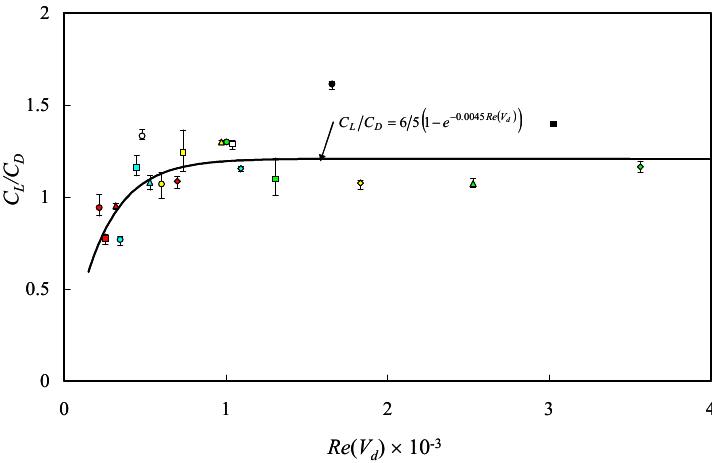
Fig. 13 Lift-drag ratio C L / C D versus the Reynolds number Re ( V d ) based on V d , for λ = 0.3, AR = 10, C = 7.2 × 10 1 − 1.6 × 10 3 and I * = 0.75 −